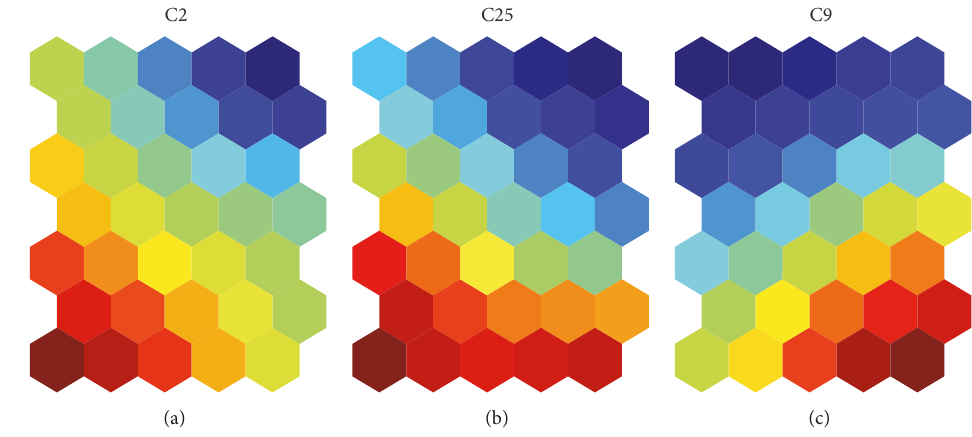
Figure 4: Prototypes of the three patterns found in the component